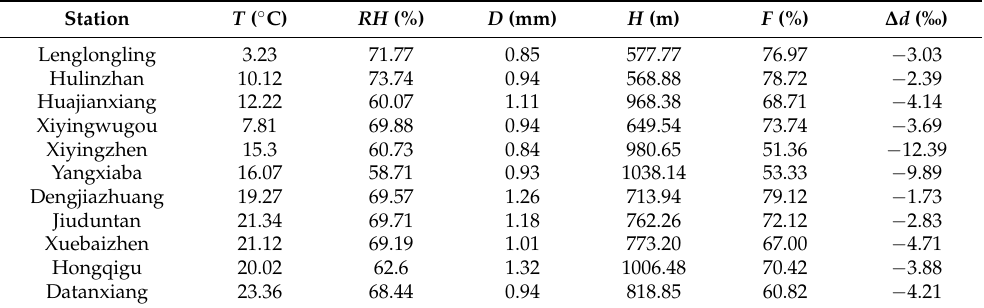
Table 2. Sub-cloud secondary evaporation and environmental factors in Shiyang River